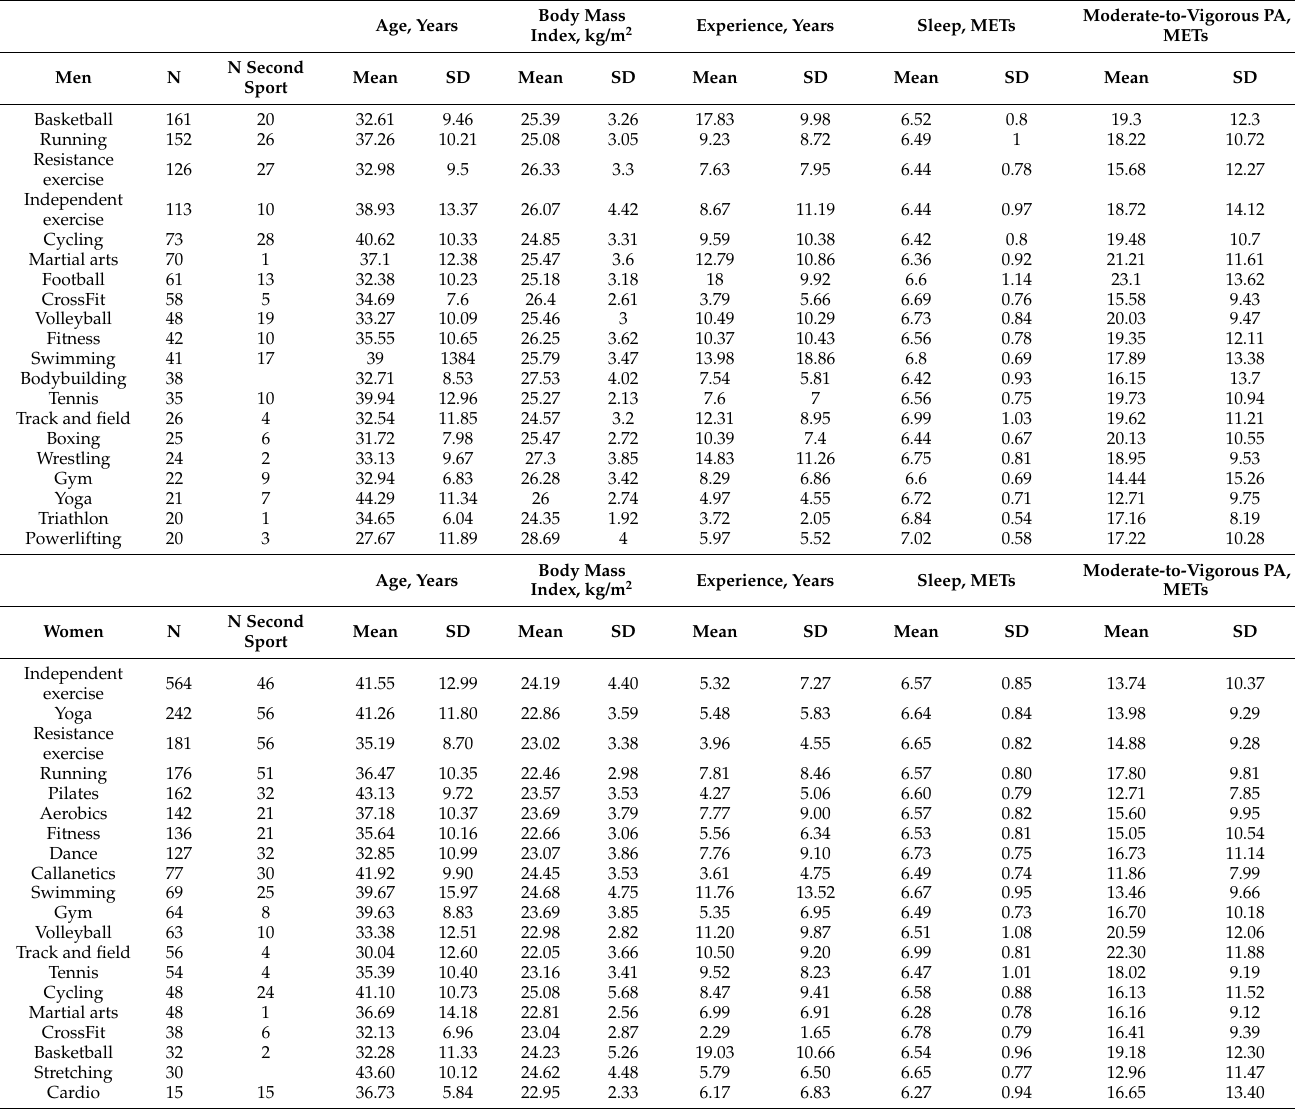
Table 3. Descriptive characteristics, body mass index, sleep, and moderate-to-vigorous physical activity in men and women who exercise, listed according to the type of